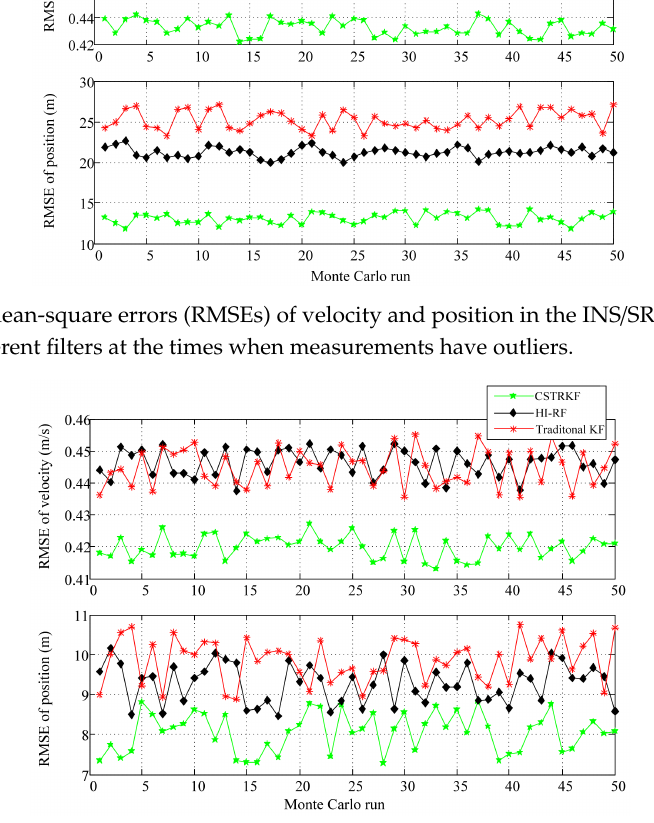
Figure 7. RMSEs of velocity and position in the INS / SRS / CNS integrated system with di ff erent filters at the times when measurements do not have